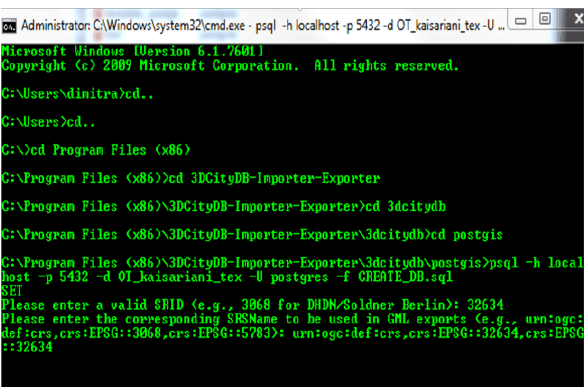
Figure 3. Creation of Database Structure in